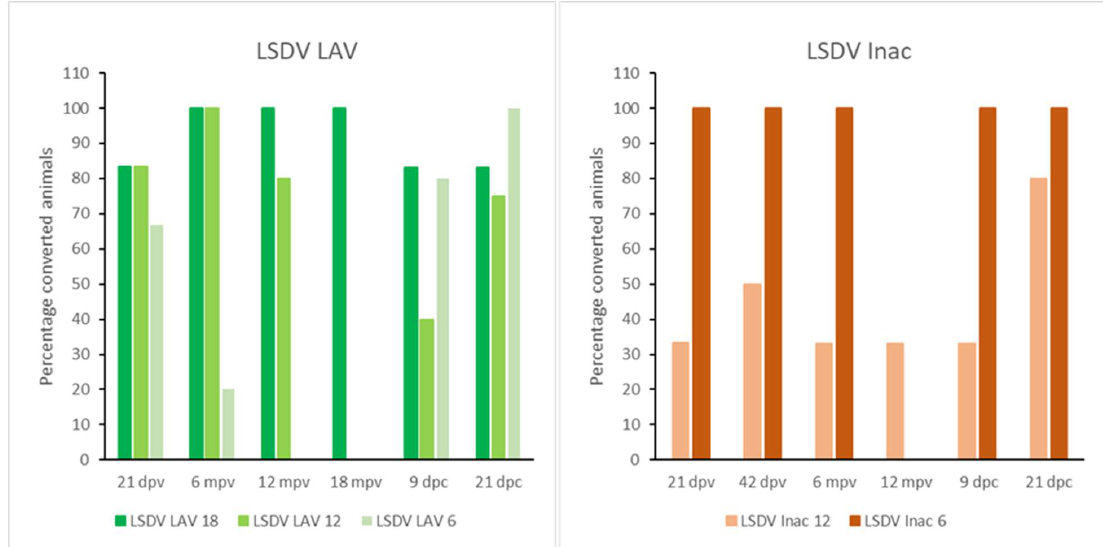
Figure 5. IFNγ results of the LSDV LAV and Inac groups; mpv: months post-vaccination. Figure 5. IFN γ results of the LSDV LAV and Inac groups; mpv: months